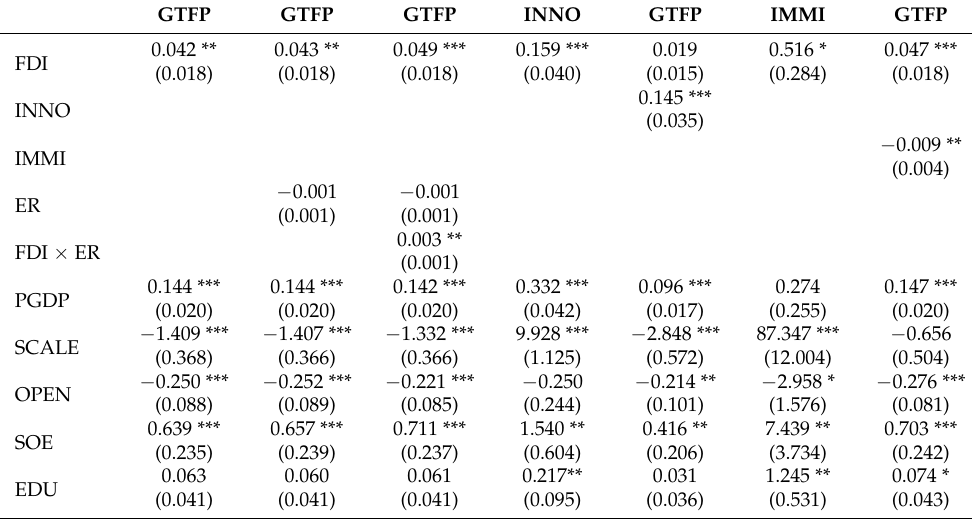
Table 7. Robustness